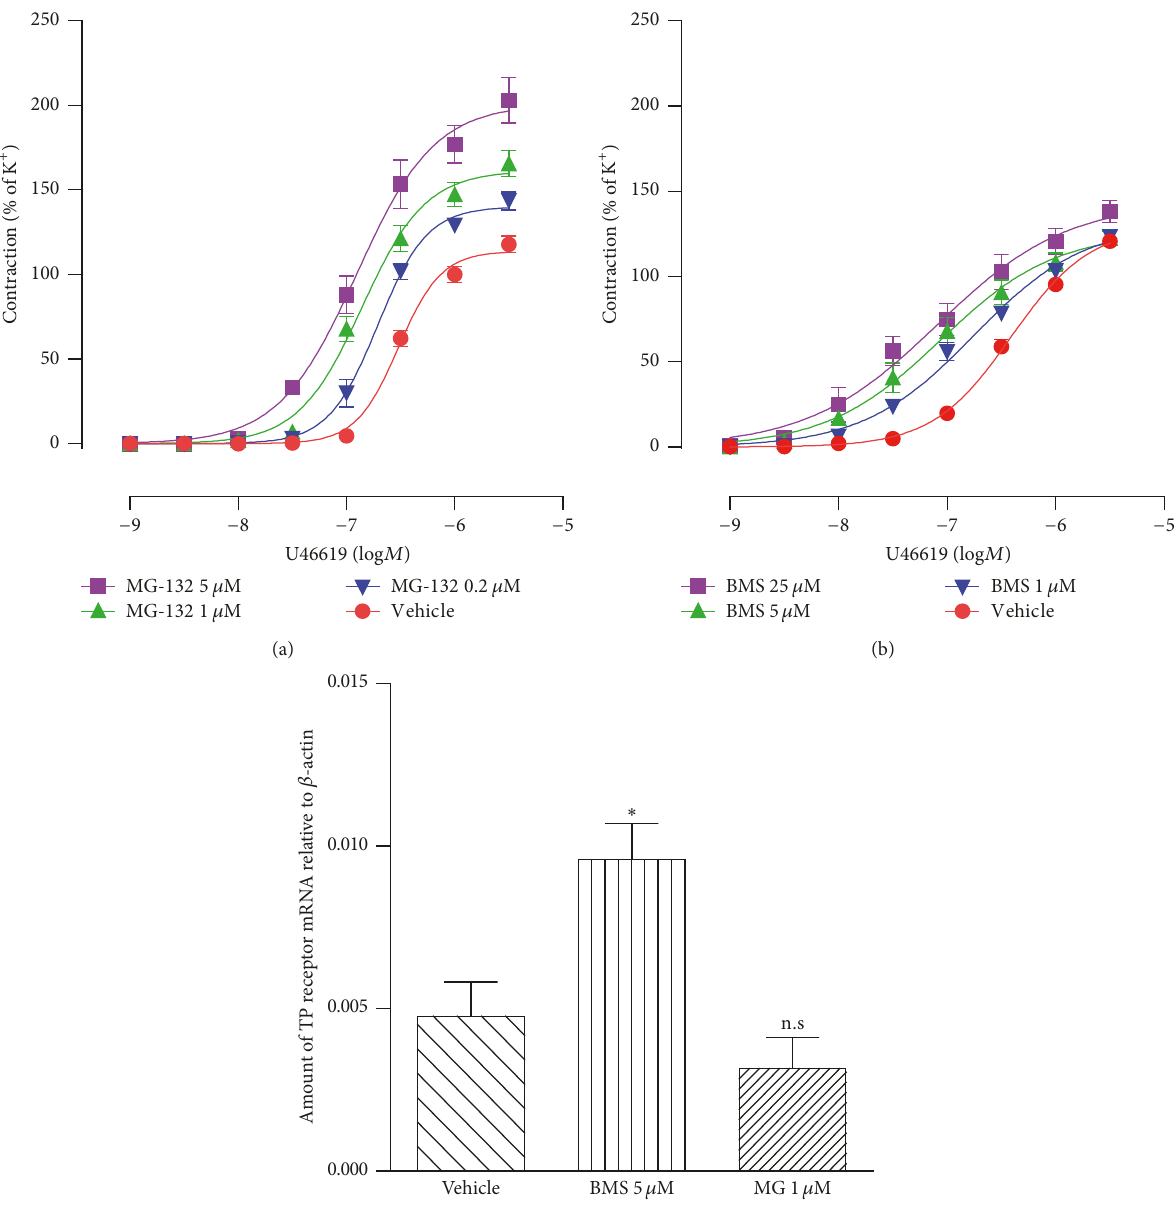
Figure 3: Effect of NF- 𝜅 B inhibitors (a) MG-132 and (b) BMS345541 on U46619-induced contraction and TP receptor (c) mRNA expression. Renal artery segments were organ cultured in presence of vehicle (DMSO) or different concentrations of MG-132 (MG, 0.2, 1, or 5 𝜇 M) or BMS345541 (BMS, 1, 5, or 25 𝜇 M) for 24 h. Data are shown as means ± SEM. Each data point is derived from 6 experiments. One-way ANOVA with Dunnett’s multiple comparison test was used. ∗ 𝑃 < 0.05 versus vehicle (DMSO) and n.s. = not significant. BMS = BMS345541, MG =